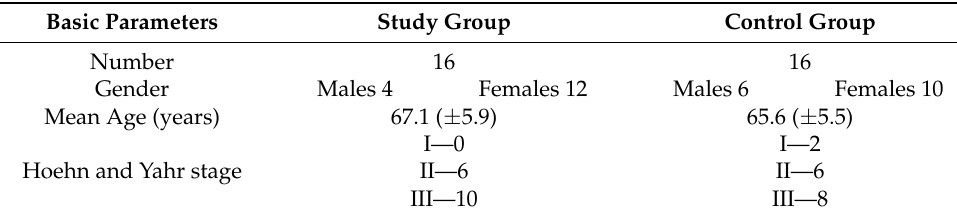
Table 1. Characteristics of the study population.